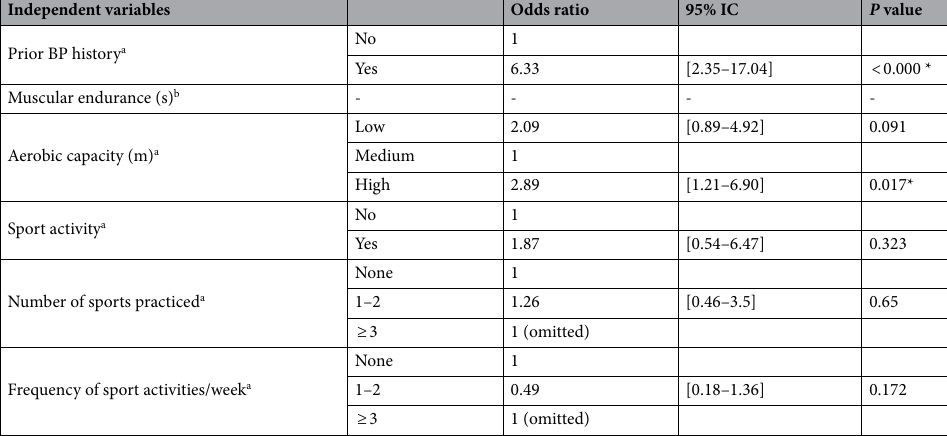
Table 4. Association between Prior BP history, muscular endurance, aerobic capacity, sport activity variables and presence of at least one BP event during the SMS survey ( n = 160). * p < 0.05; a Variables with p < 0.2 to the bivariate regression model were added to the multivariate regression model and adjusted for age, sex and growth spurt occurrence; b : variables with p > 0.2 in the bivariate correlation test and thus not included in the stepwise multivariate regression model.